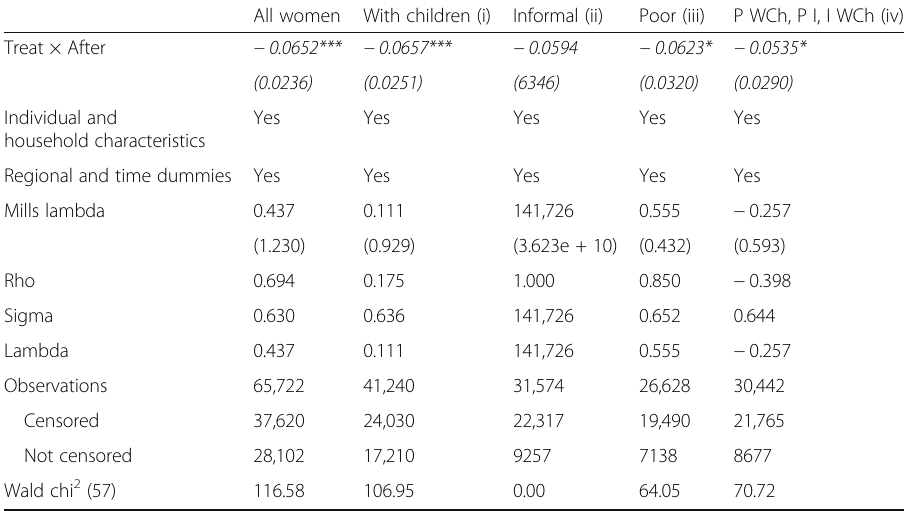
Table 13 Effect of the AUH on labor intensity. Alternative control groups All women With children (i) Informal (ii) Poor (iii) P WCh, P I, I WCh (iv) Treat ×